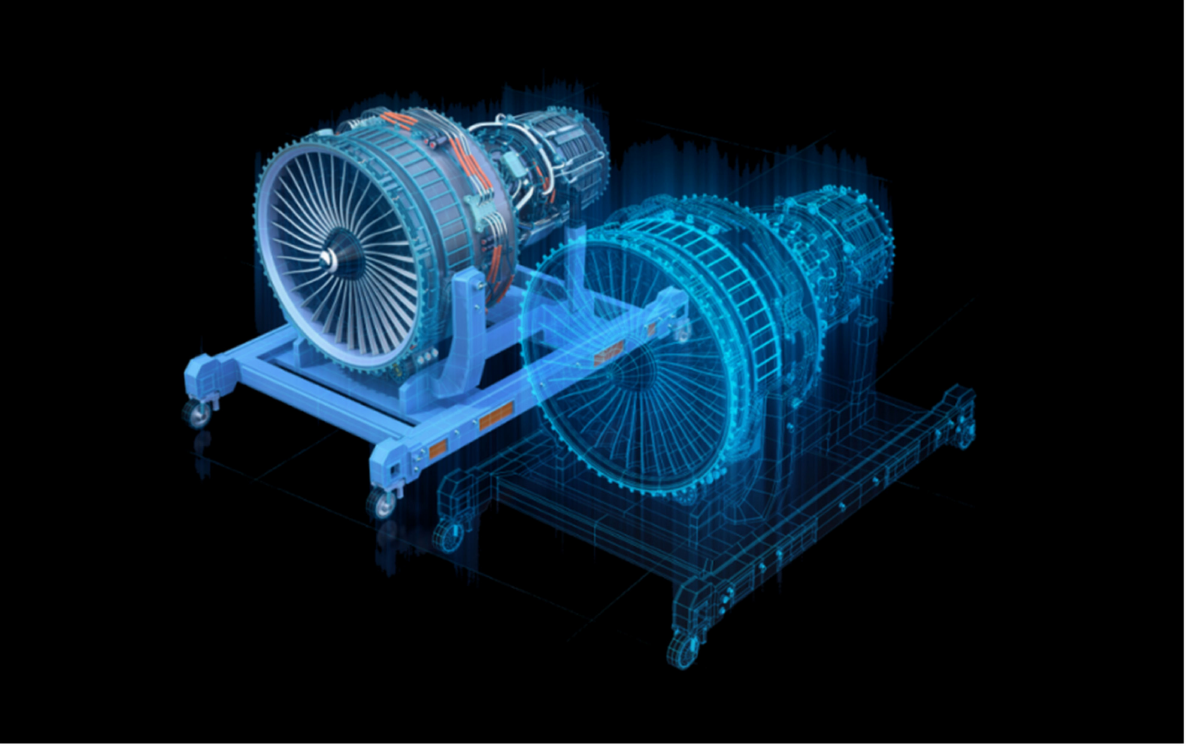
Figure 5. Real object and digital-twin model